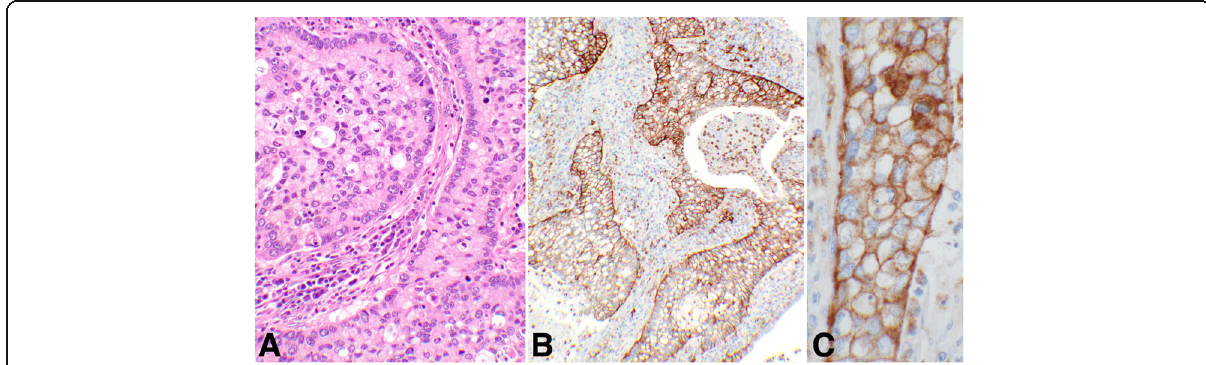
Fig. 3 Score 2 in adenosquamous carcinoma. An example of Score 2b adenosquamous carcinoma showing the PD-L1 reaction involving 100% of the tumor cells (#6, Table 4). a shows hematoxylin & eosin stain of the glandular organization of the tumor cells with adjacent stromal tissue. The center of the glandular structures contains solid nests of cells with squamoid differentiation (objective 20×). b demonstrates the PD-L1 membrane staining of all tumor cells (objective 10×). c shows complete circumferential cell membrane staining of the tumor cells with 2+ intensity (objective 40×). This intensity may be interpreted as 3+ by some other